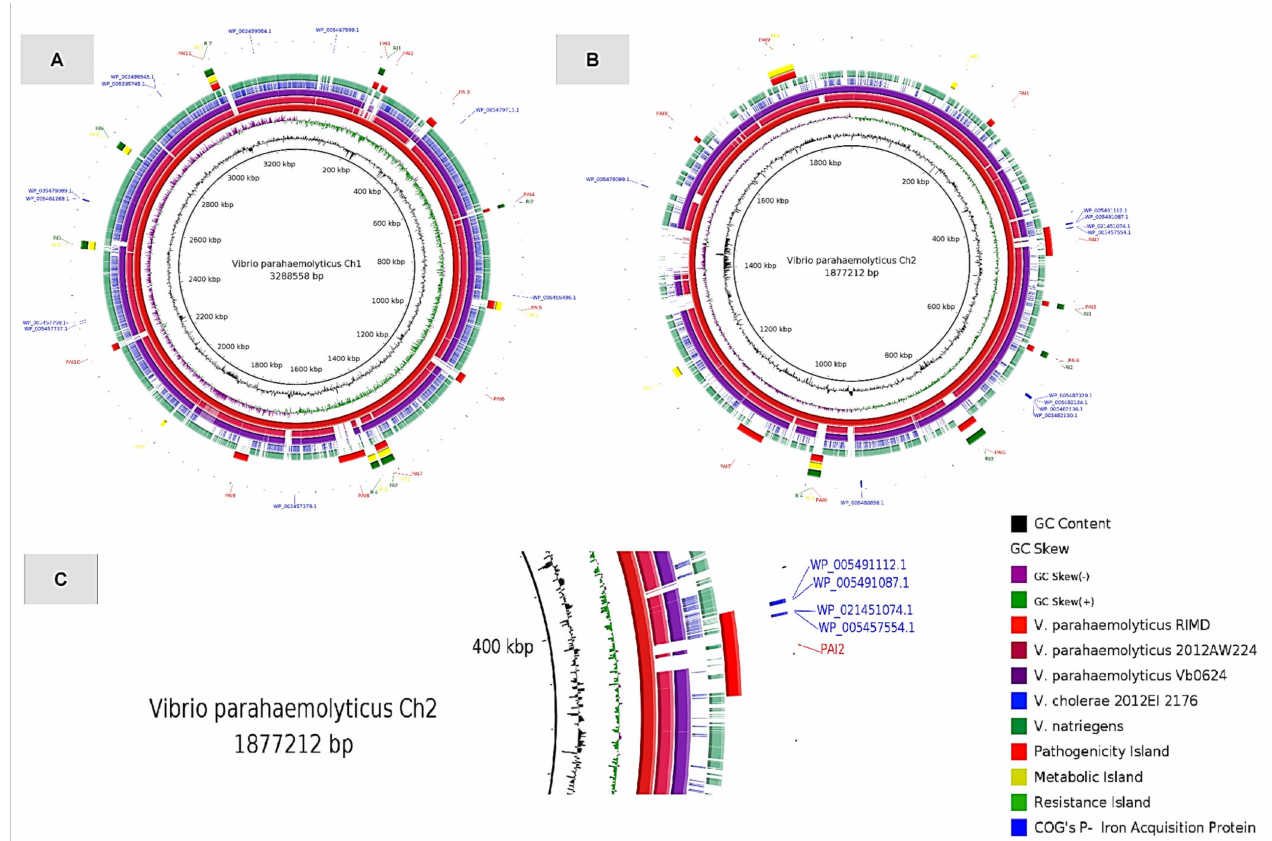
Figure 2. Genomic islands present in the genome of Vibrio parahaemolyticus . The BRIG analysis for the two Vibrio spp. chromosomes (Ch1- A ; Ch2- B ). In the order: Vibrio parahaemolyticus , strains RIMD, Vb0624, and 2012AW224, Vibrio cholerae strain 2012El 2176, Vibrio natriegens , strain COUG 16373. On the outer ring are plotted the genomic islands. In red are the pathogenicity islands, in green are the resistance islands, and in yellow are the metabolic islands predicted by GIPSy. In blue, there are small, enumerated traces, which correspond to the position of the iron metabolism proteins. C -Highlighted is the region of the proteins present in PAI2, in order: WP_005491112.1, WP_005491087.1, WP_021451074.1 and WP_005457554.1